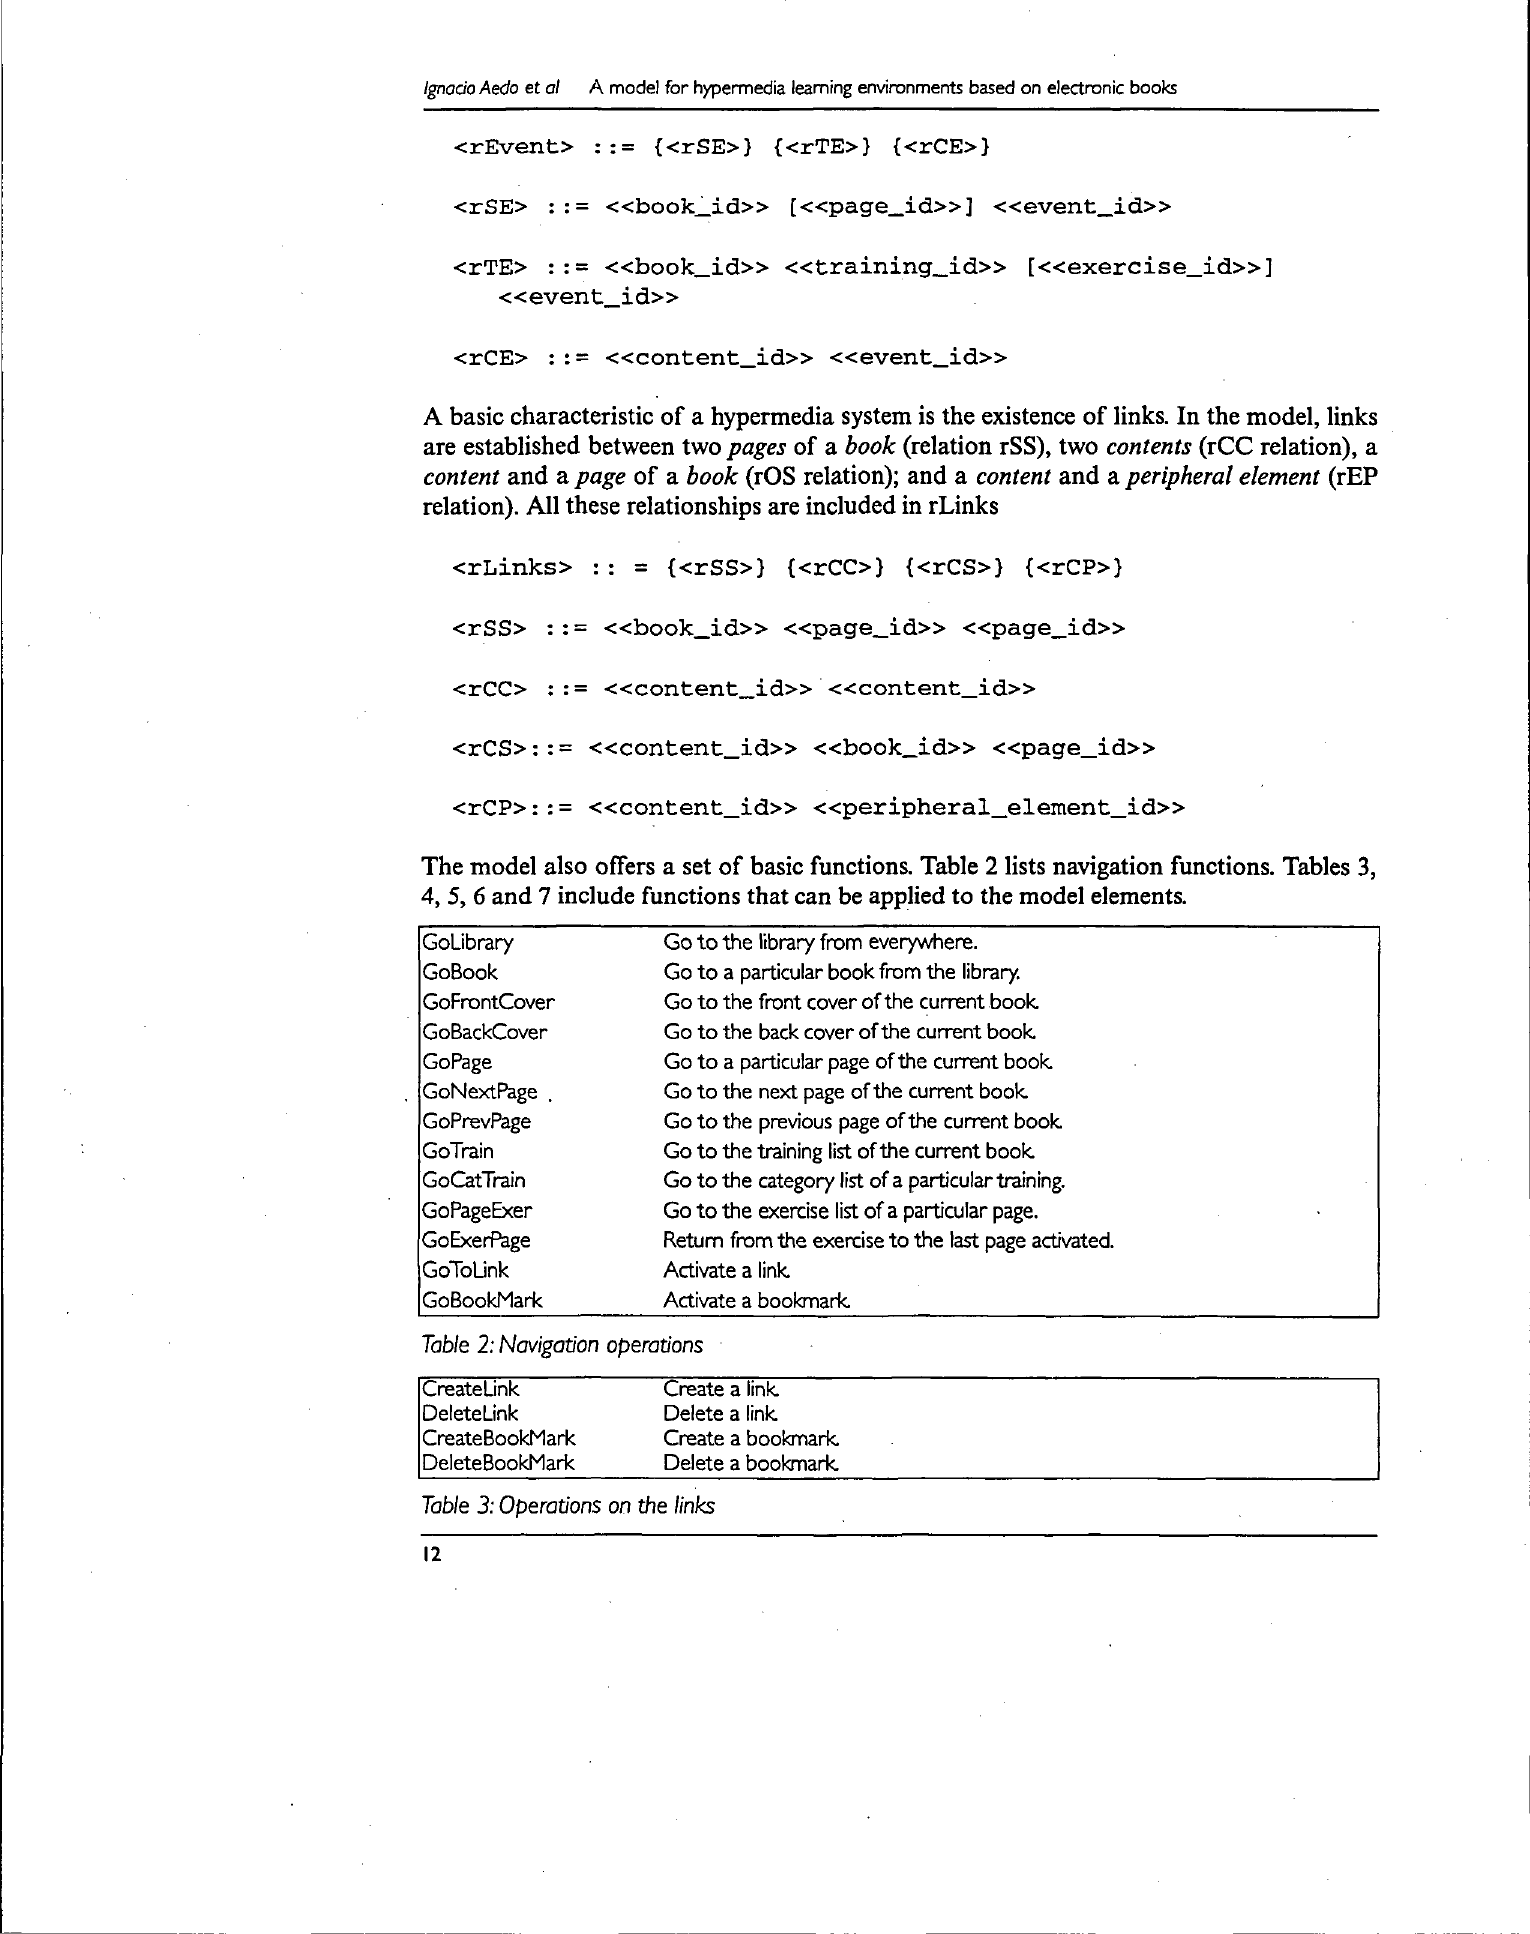
Table 3: Operations on the